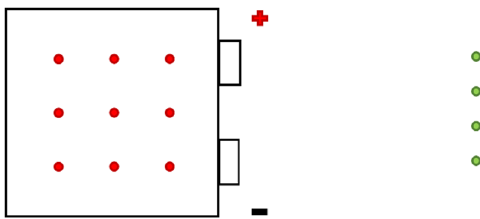
Figure 5. Scheme of the thermocouples positions on the surface of the pouch cell (red) and at different positions inside the TR reactor (green).